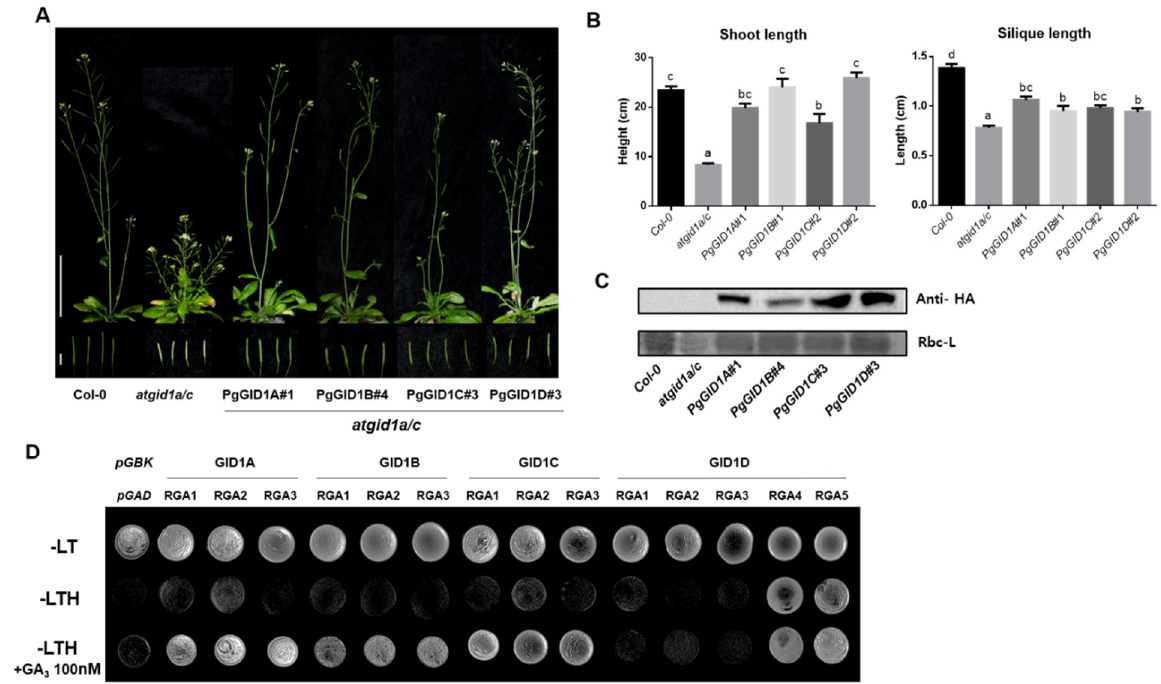
Figure 3. Complementation of the Arabidopsis gid1 loss-of-function mutant via PgGID1 overexpression. ( A ) Rescue of the GA-insensitive dwarf phenotype of the atgid1a/c double mutant by overexpression of PgGID1A–D genes. Scale bar = 5 cm ( top panel) and 0.5 cm ( bottom panel). ( B ) Measurement of the length of shoots and siliques shown in ( A ). Error bars represent the standard error ( n > 12). Different lowercase letters indicate statistically significant differences ( p < 0.05; one-way ANOVA, followed by Tukey’s multiple range test). ( C ) Western blot analysis of PgGID1A–D protein levels in atgid1a/c plants. ( D ) Yeast two-hybrid assay. To test the interaction between PgGID1s and PgRGAs, PgGID1A–D -carrying pGBKT7 constructs (bait) were co-expressed with PgRGA1–5 -harboring pGADT7 constructs (prey) in yeast cells, which were grown on media (-LTH) supplemented with or without 100 nM GA 3.